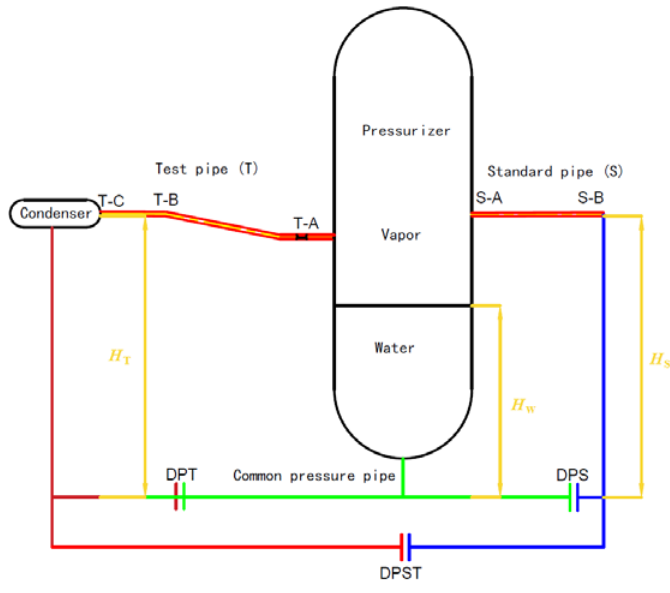
Figure 4. Principle of CCFL identification.